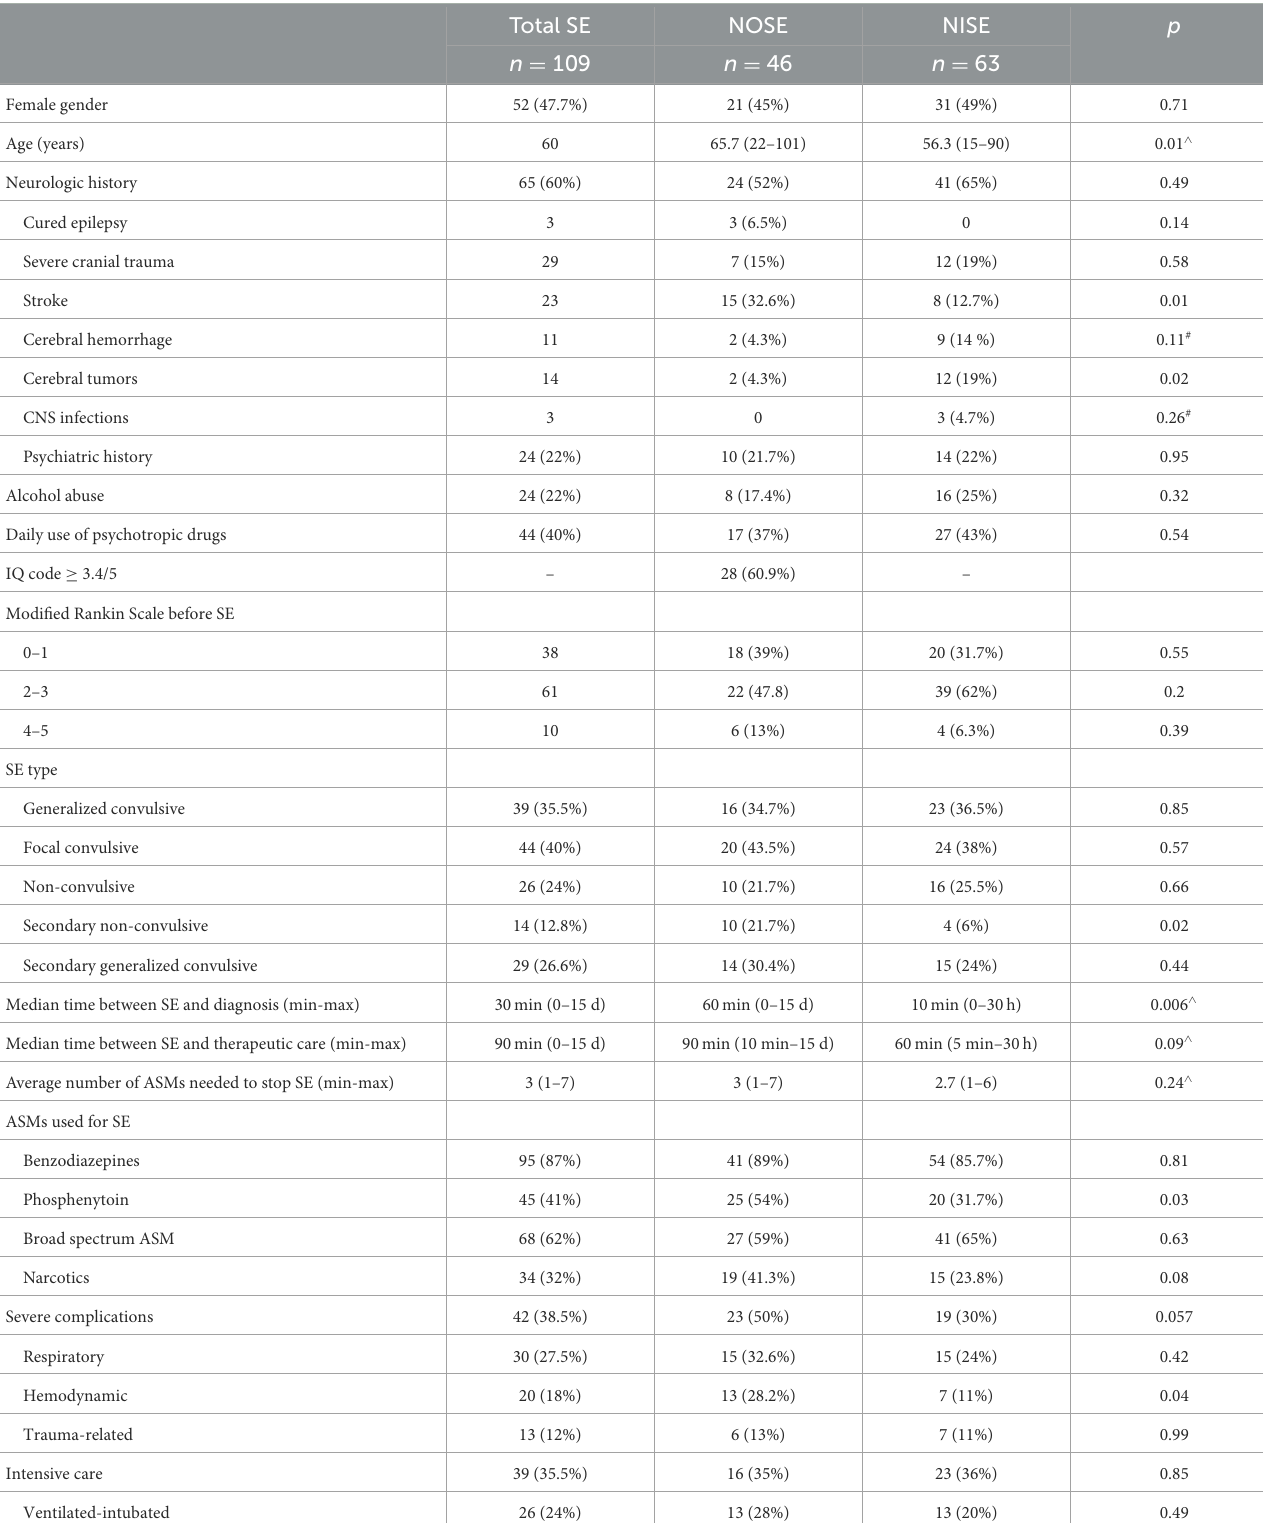
TABLE 1 Clinical characteristics of NOSE and NISE